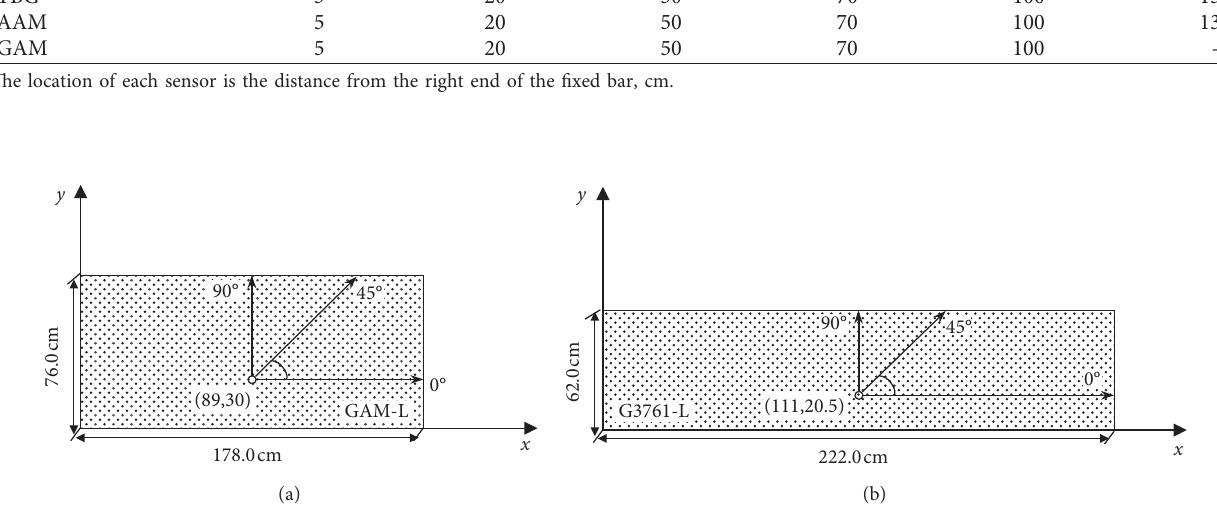
Figure 2: The diagram of sensor placement plate-shaped rock. (a) GAM-L. (b)